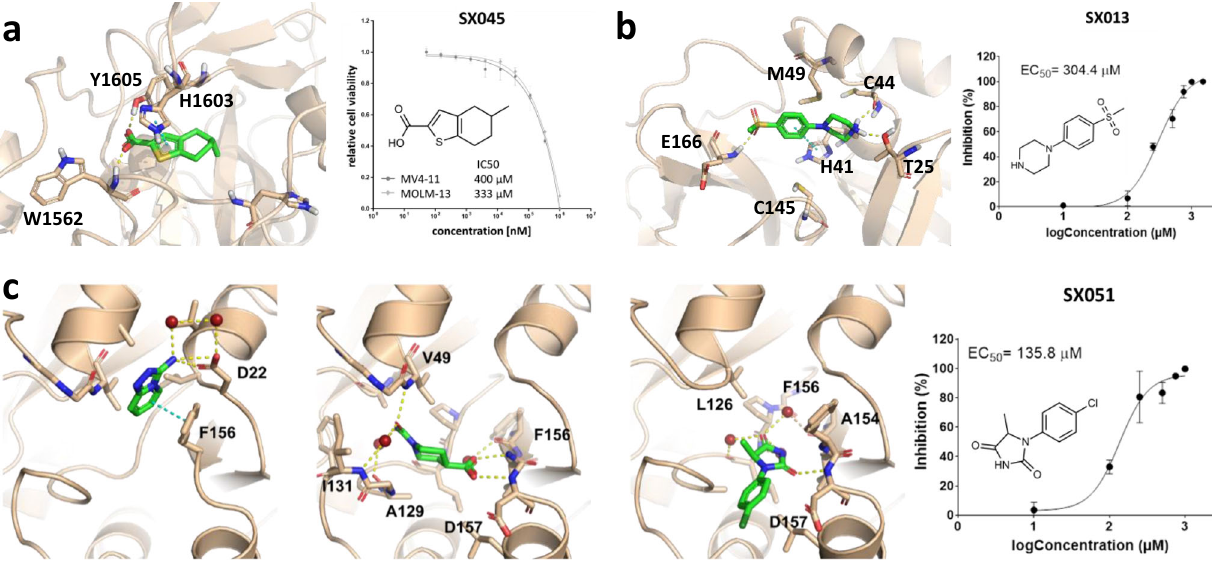
Fig. 4 Binding poses and cellular activities of SpotXplorer0 hits against challenging and current targets. a Predicted binding pose of the fragment SX045 (green) in the binding pocket of the SETD2 histone methyltransferase. The fragment decreases the viability of MV4-11 and MOLM-13 leukemia cells in a dose-dependent manner (see Supplementary Information, section 8), with IC 50 values of 400 µ M and 333 µ M, respectively. b X-ray structure of the fragment SX013 in complex with the main protease (3CLPro) of the SARS-CoV-2 virus (PDB entry 5RHD). The fragment inhibits the SARS-COV-2-induced mortality of Vero E6 cells with an EC 50 of 304 µ M. c X-ray structures of fragments SX005, SX048 and SX051 (left to right) in complex with the NSP3 macrodomain of the SARS-CoV-2 virus (PDB entries 5S4G, 5S4H, and 5S4I). The fragments show antiviral activities with EC 50 values in the high micromolar range in the cellular assay. (In the IC 50 and EC 50 plots, data are presented as mean values + / − SD, calculated from n = 3 biologically independent samples.) Source data are provided in the Source Data fi